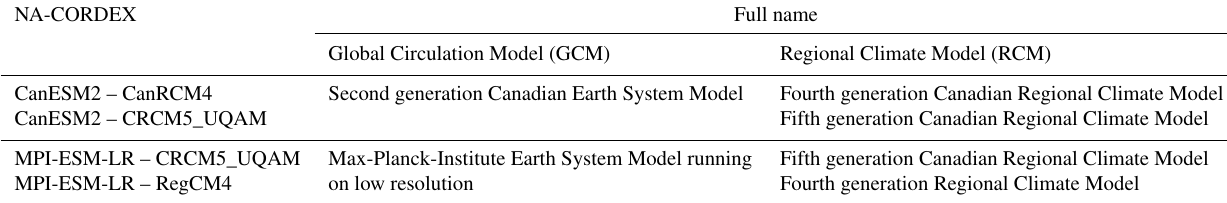
Table 3. GCMs–RCMs chosen in the North America COordinated Regional climate Downscaling EXperiment (NA-CORDEX)